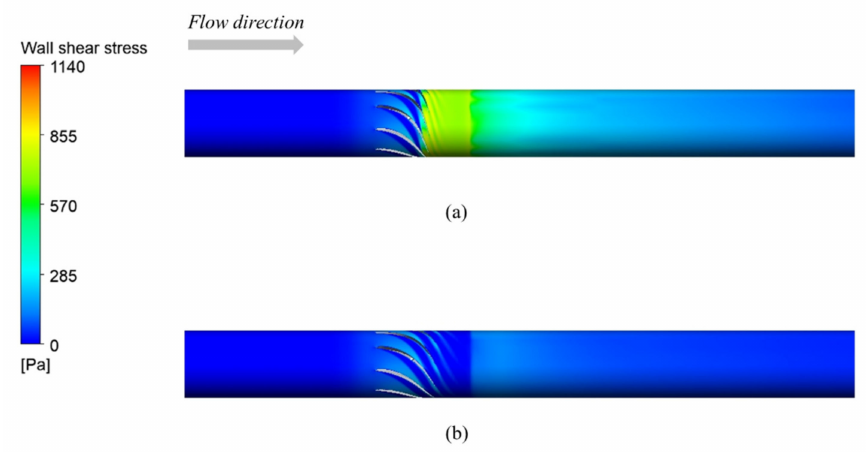
Figure 9. Distribution of wall shear stress: ( a ) Case 6, ( b ) Case 8.